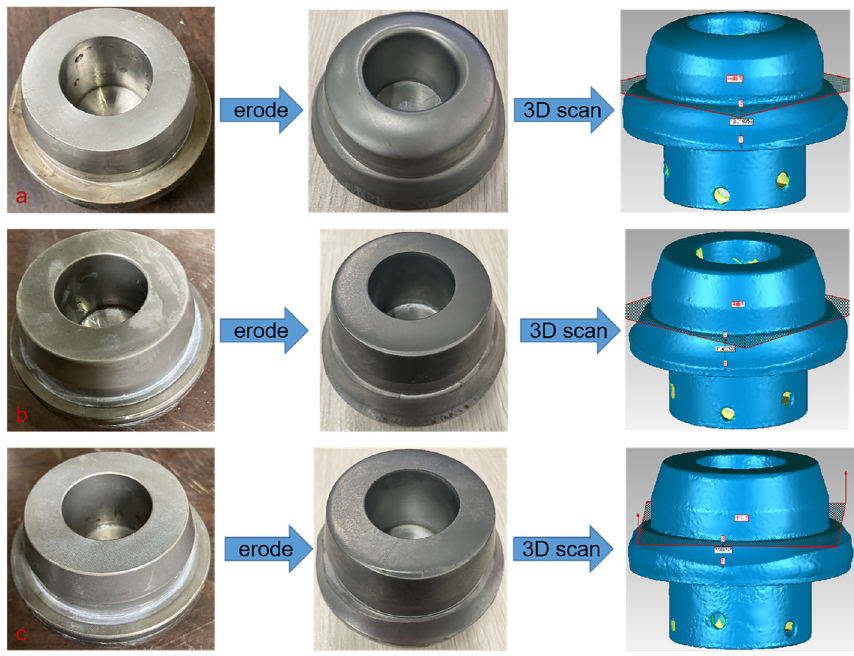
Figure 12. Surface morphology of valve core before and after erosion test. Group a : uncoated valve core. Group b : polish coating valve core. Group c : texture coating valve core.